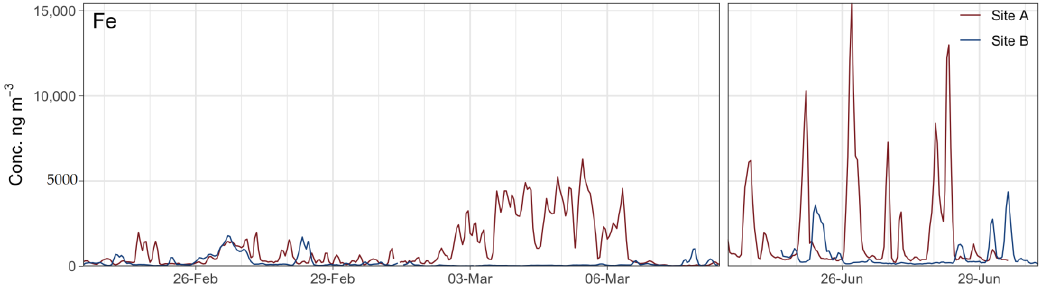
Figure 3. Temporal trends (in ng m −3 ) of Fe measured simultaneously at the two sites in the fine fraction.